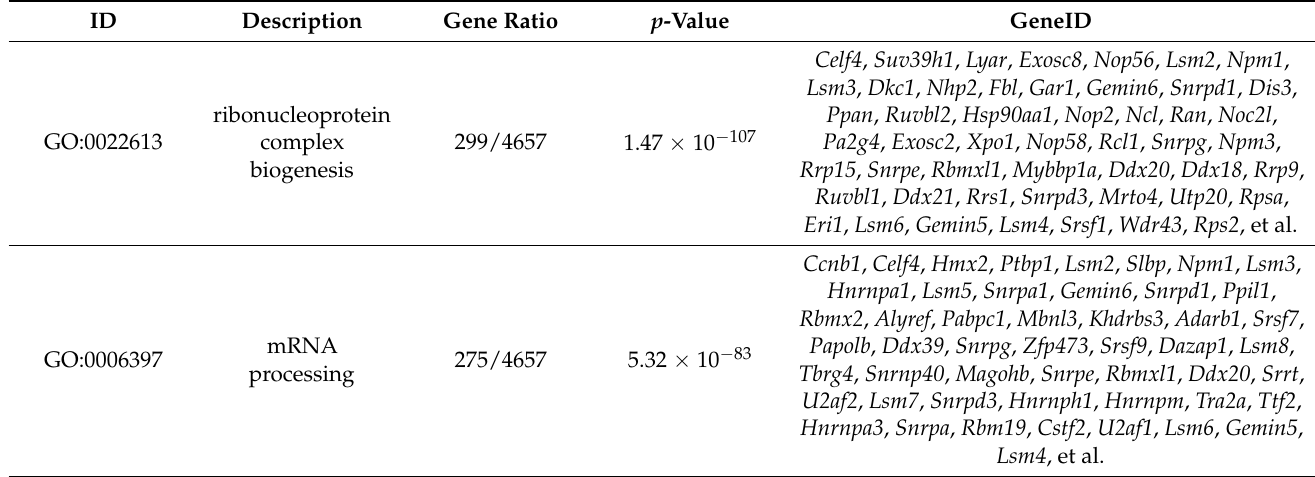
Table 2. Two examples of functional terms associated with genes downregulated during myoblast differentiation.